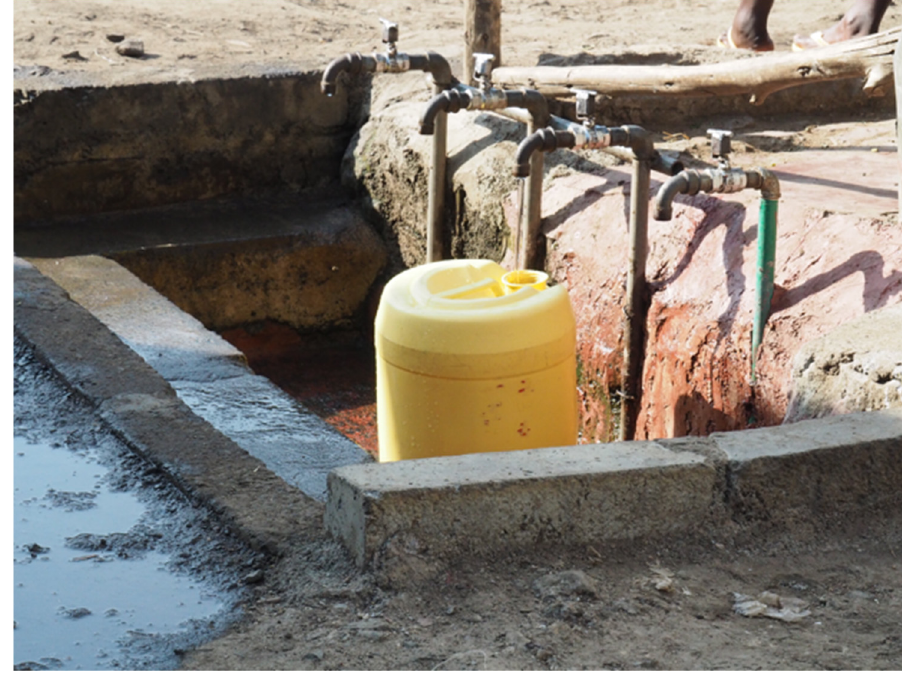
Figure 3. Typical Yard ‐ shared water point in Mukuru, Nairobi.